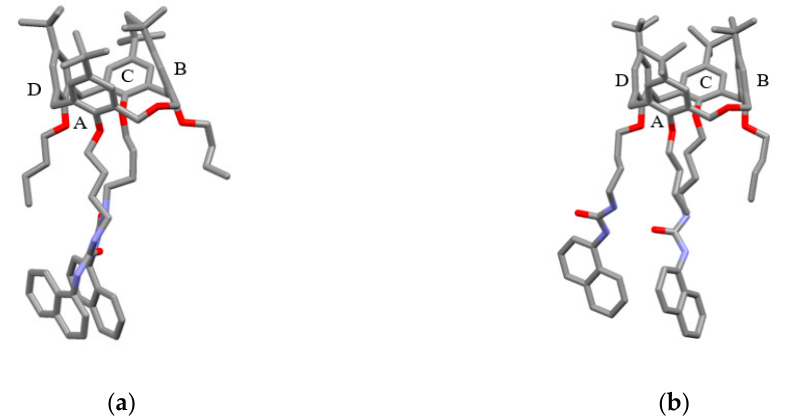
Figure 1. Solid state structures of ( a ) 5a and ( b ) 5b . The structures, with very similar cone conformations, show significant differences in conformation of the lower rim substituents. The atomic species are represented in CPK colours. Hydrogen atoms are omitted for clarity.